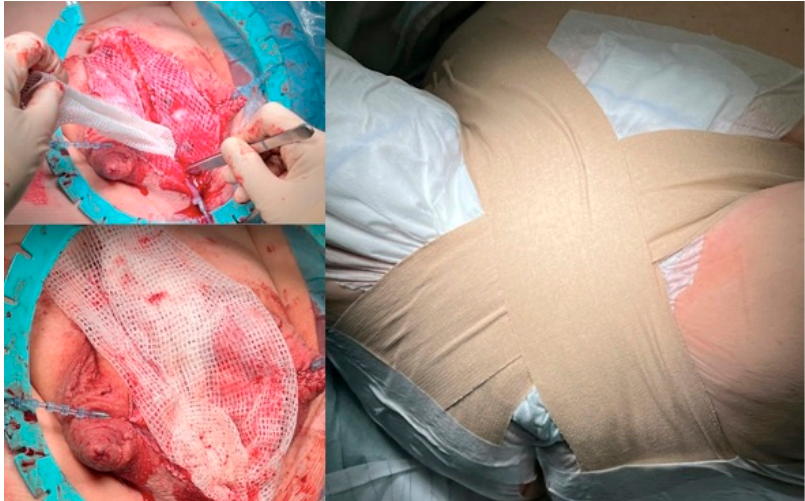
Figure 6. Dressing after Stage 1 Surgery.